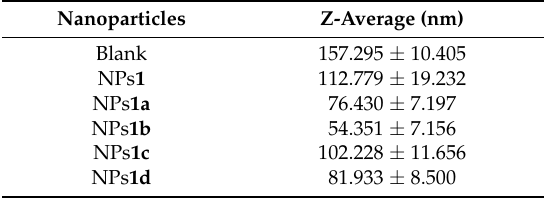
Table 5. Average diameter of NPs (nm) obtained by image analysis software (ImageJ 6.0) from TEM. All data were obtained from 100 particles and values are expressed as mean ± SD.